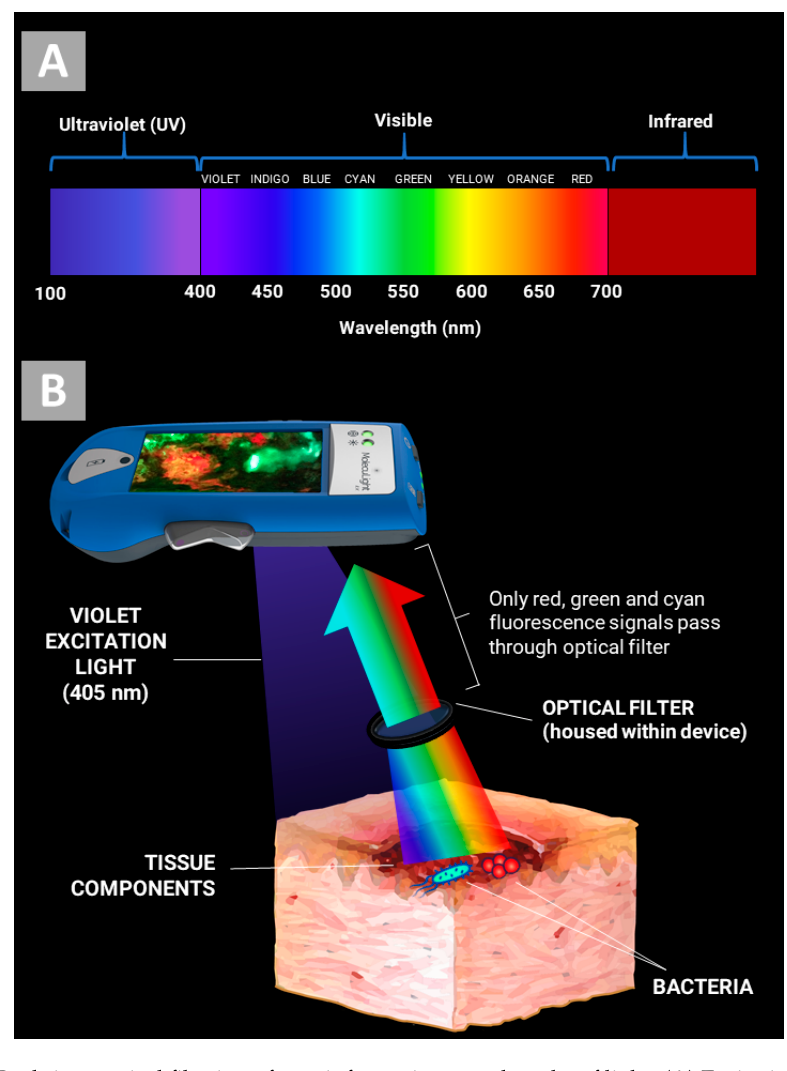
Figure 1. Real-time optical filtering of non-informative wavelengths of light. ( A ) Excitation of tissues and bacteria with 405 nm violet light results in a spectrum of fluorescence signals which span the spectrum of visible light. ( B ) Optical filters allow fluorescence signals only from information-rich wavelength bands and prevent reflected violet light from contaminating the image, without any digital processing.